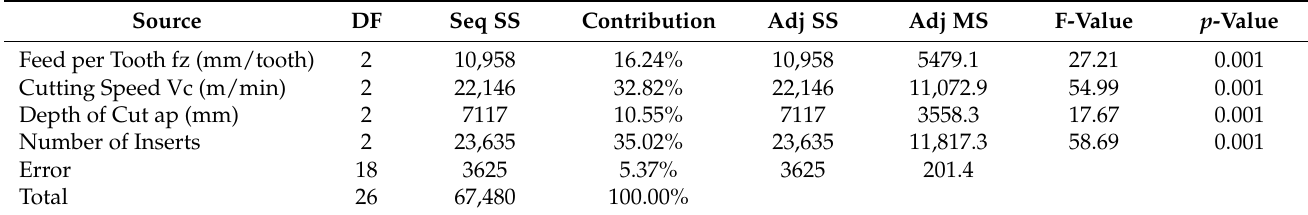
Table 7. ANOVA results for burr width on up-milling side.